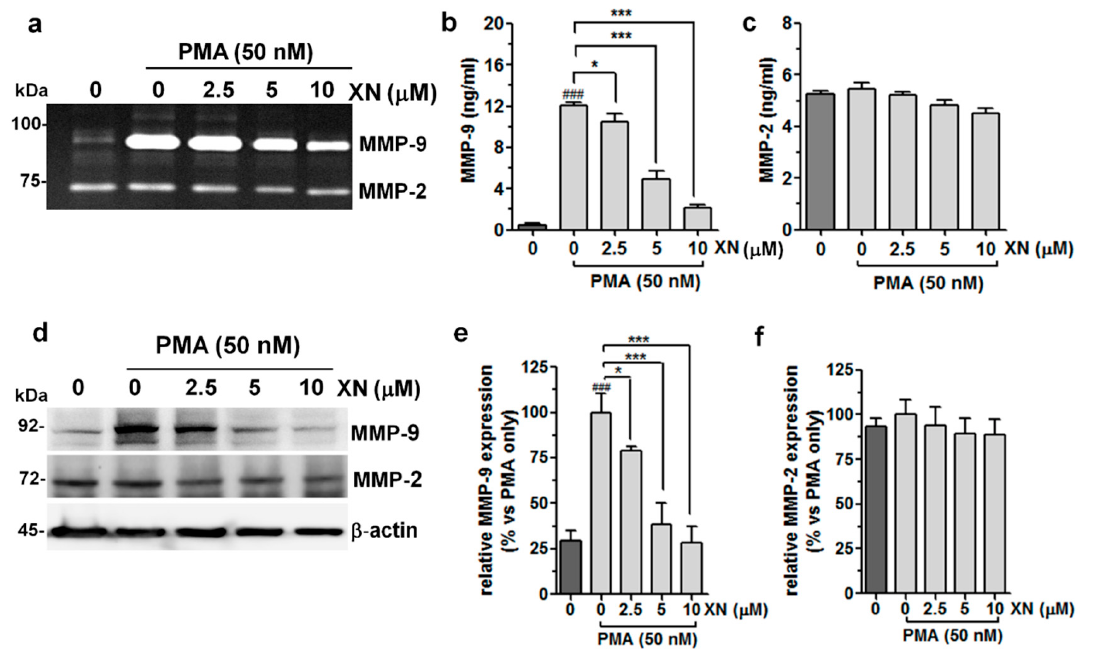
Figure 2. Effects of XN on the activity/expression of MMP-9 and MMP-2 in PMA-stimulated A549 cells. The cells were pre-incubated with XN for 4 h, followed by PMA co-stimulation for 24 h. ( a ) The gelatinolytic activity of MMP-9 and MMP-2 was assayed using gelatine zymography. The concentrations of MMP-9 ( b ) and MMP-2 ( c ) in the supernatants were determined with the ELISA assay. The results are the mean ± SD of three independent experiments, * p < 0.05, *** p < 0.001 in comparison to the PMA-only treatment; ### p < 0.001 in comparison to the non-stimulated cells; one-way ANOVA test. ( d ) The levels of MMP-9 and MMP-2 protein expression from whole cell lysates were measured with the Western blot analysis. β -actin was used as an internal control. The intensity of bands for MMP-9 ( e ) and MMP-2 ( f ) from the Western blot was quantified by densitometry analysis, where the untreated PMA-induced cells represented 100%. The results are the mean ± SD of three independent experiments, * p < 0.05, *** p < 0.001 in comparison to the PMA-only treatment, ### p < 0.001 in comparison to the non-stimulated cells; one-way ANOVA test.